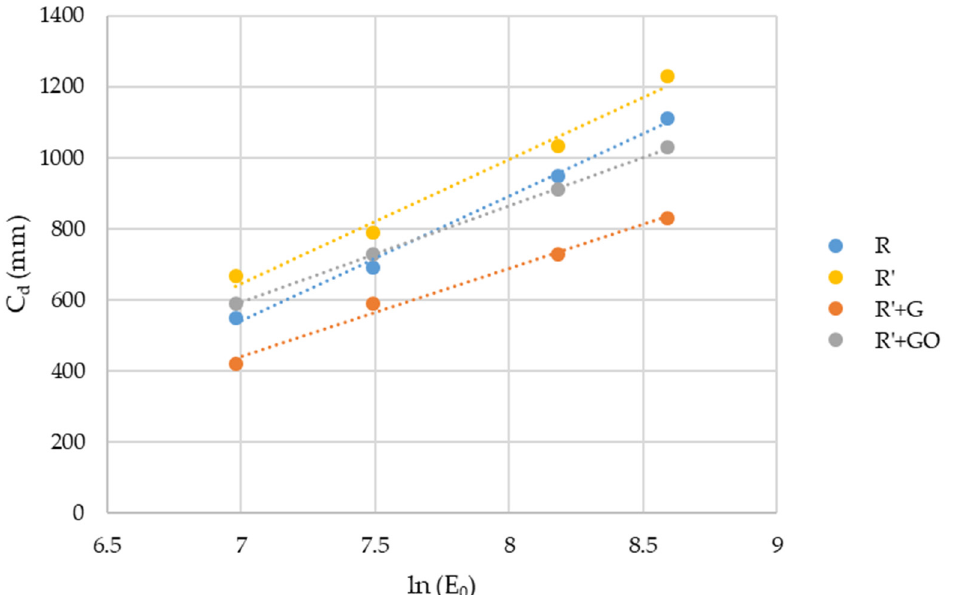
Figure 4. Jacobs’ working curve of R, R’ and R’+GBN.